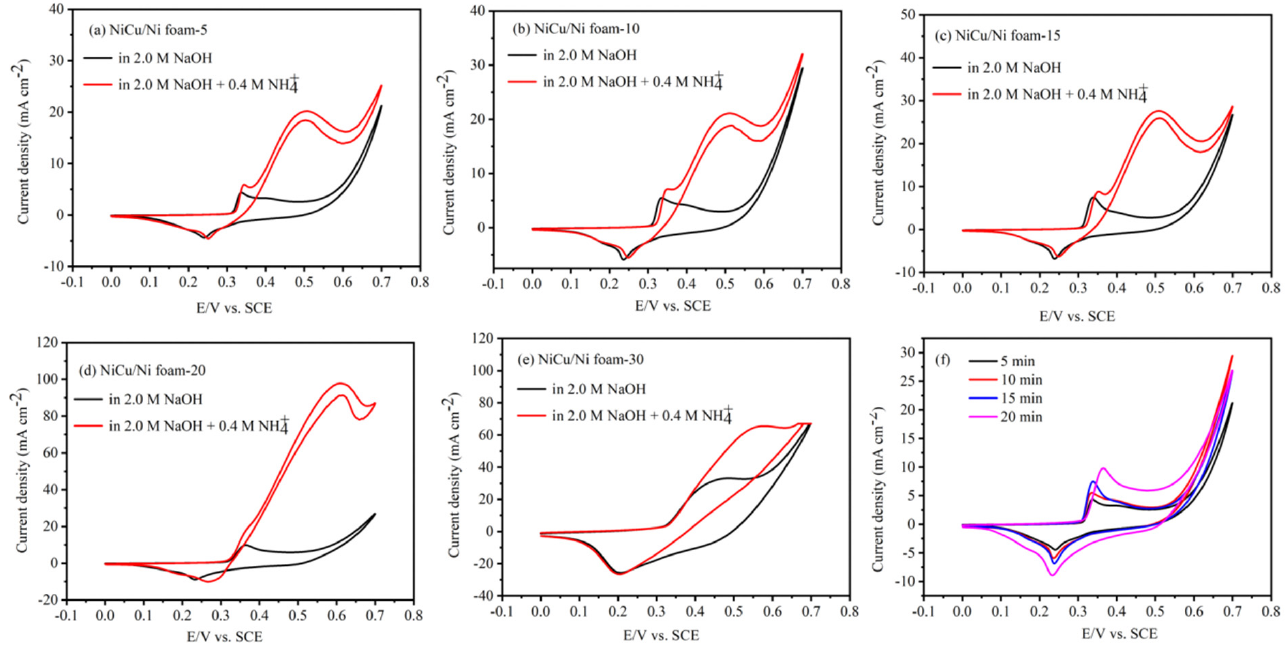
Figure 4. CV curves of different electrodes in 2.0 M NaOH + 0.4 M NH 4+ with scanning rate of 20 mV s − 1 . ( a – e ) Electrodes prepared in the presence of CuCl 2 solution with different sonication times; ( f ) CV curves of different electrodes with different sonication times in 2 M NaOH at scanning rate of 20 mV s − 1